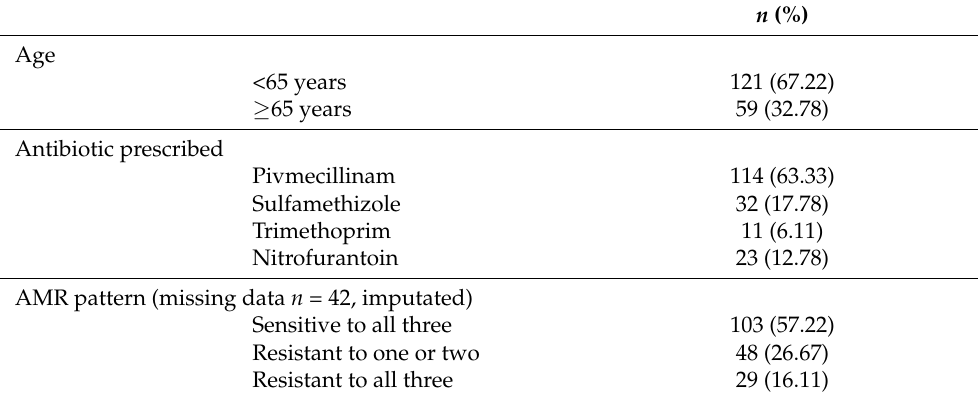
Table 1. Baseline characteristics.